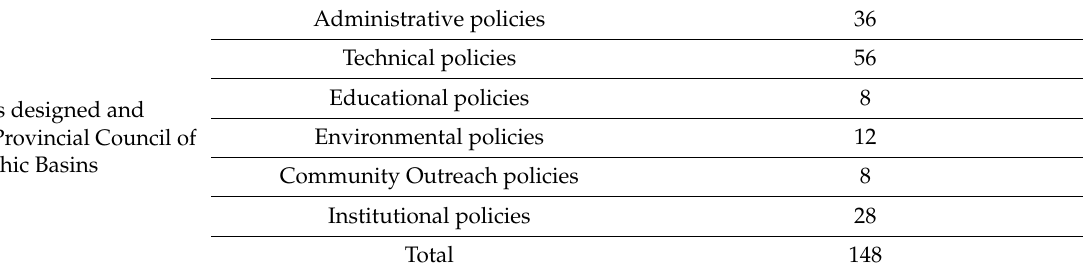
Table 4. Dynamics of management policies related to deforestation in the San Juan River Basin.